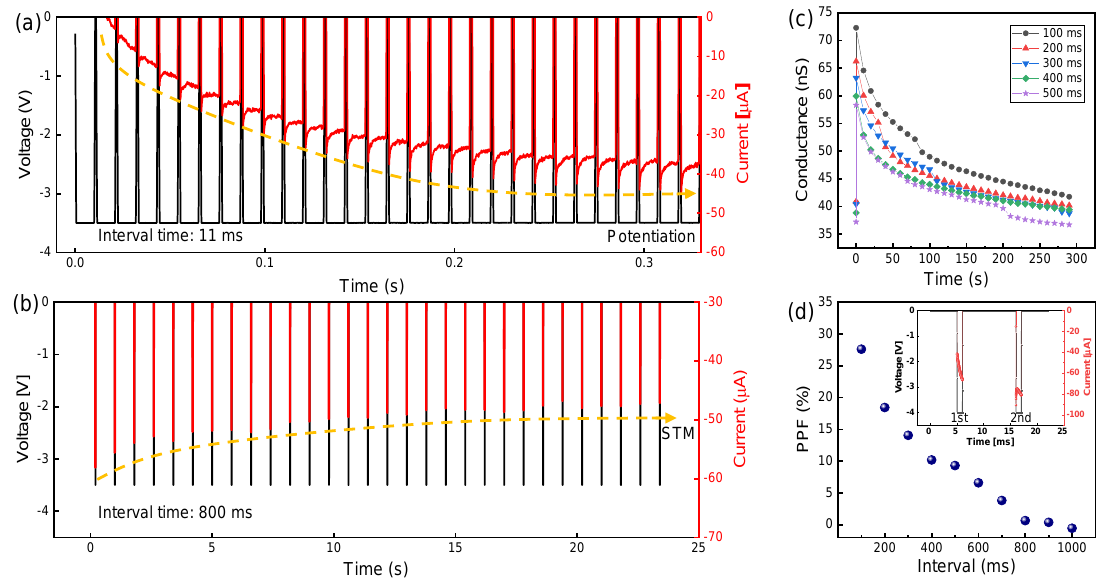
Figure 4. Potentiation and depression characteristics of TiN/Ti/TiO 2 /SiO x /Si device: ( a ) Pulse-width- controlled conductance change; contour maps of ( b ) potentiation and ( c ) depression as a function of pulse voltage and width; ( d ) normalized conductance in different pulse widths; ( e ) nonlinearity and dynamic range as a function of pulse width.